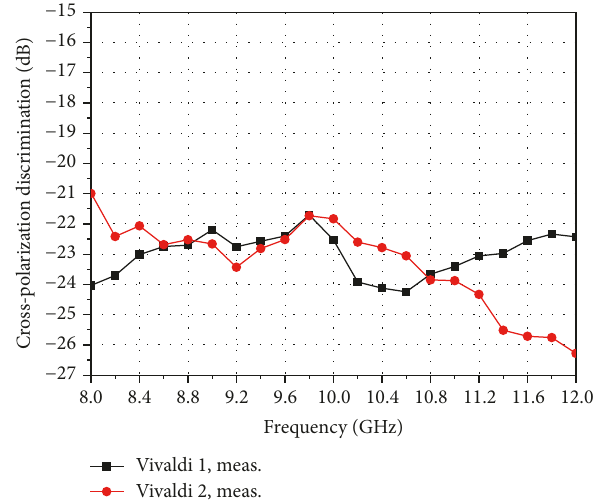
Figure 11: Variation of the cross-polarization discrimination for Vivaldi 1 and Vivaldi 2.